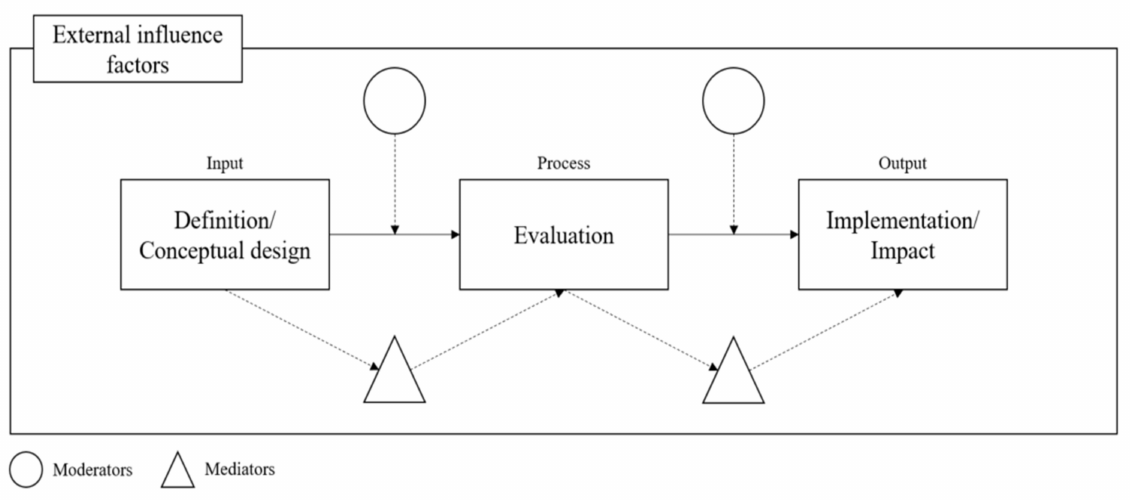
Figure 4. Proposed conceptual model framework. Source: Own